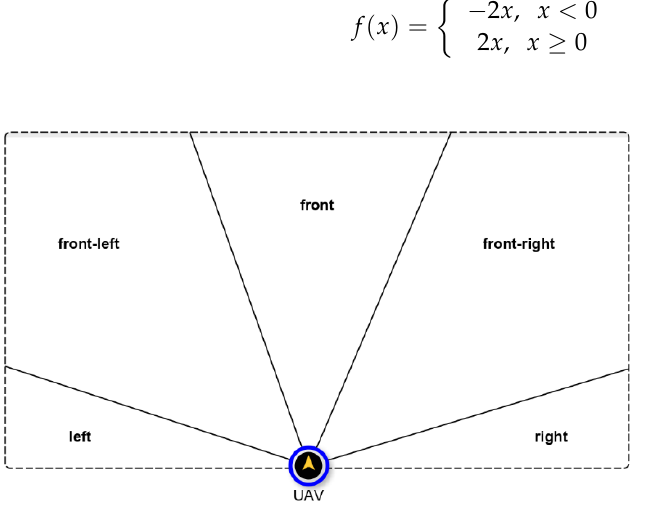
Figure 5. The UAV’s view field segmentation. Equation (5) establishes the limit between the region classified as front and the re- gions classified as front left and front right when x and f(x) represent the x-coordinate and y-coordinate , respectively. Equation (6) establishes the limit between the region classified as front left and left and front right and right. Moreover, a local matrix of N · M dimensions is applied over each ROI to generate additional fuzzy spatial information when two or more ROIs are close to each other. Equations (5) and (6), and their reflecting functions in relation to the x axis are applied for segmenting this local matrix to establish spatial relationships between